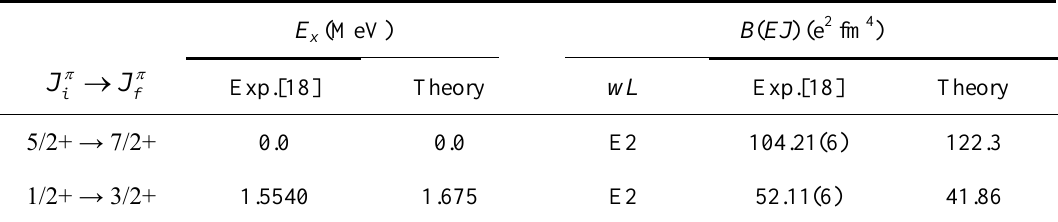
Table 1: Excitation energies, reduced transition probabilities for the positive parity states of 25 Mg nucleus.